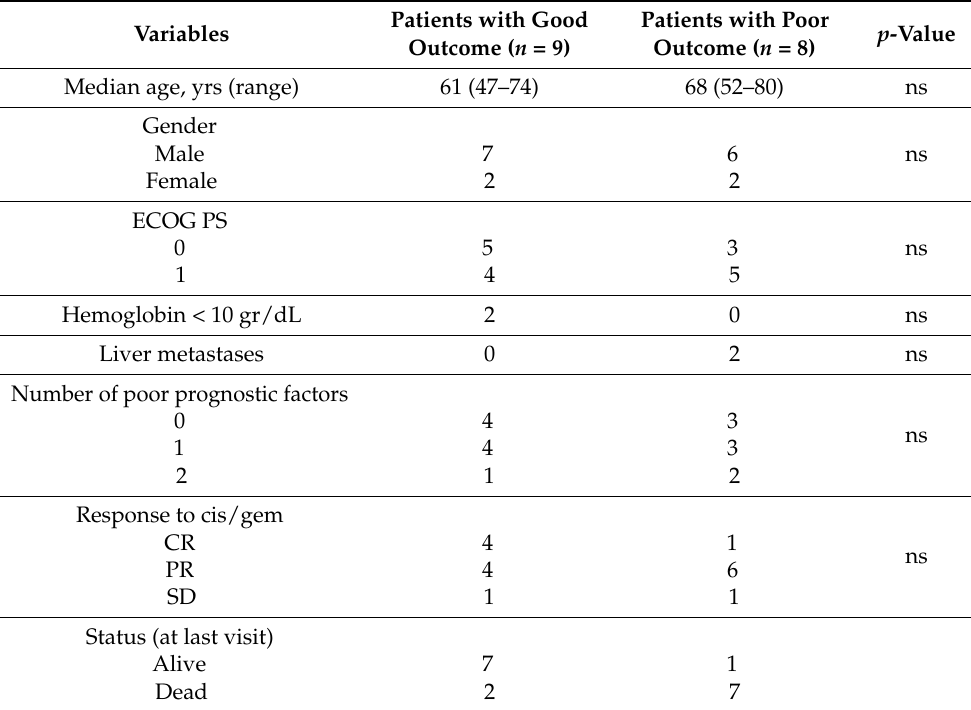
Table 1. Baseline characteristics of the 17 patients included in the present